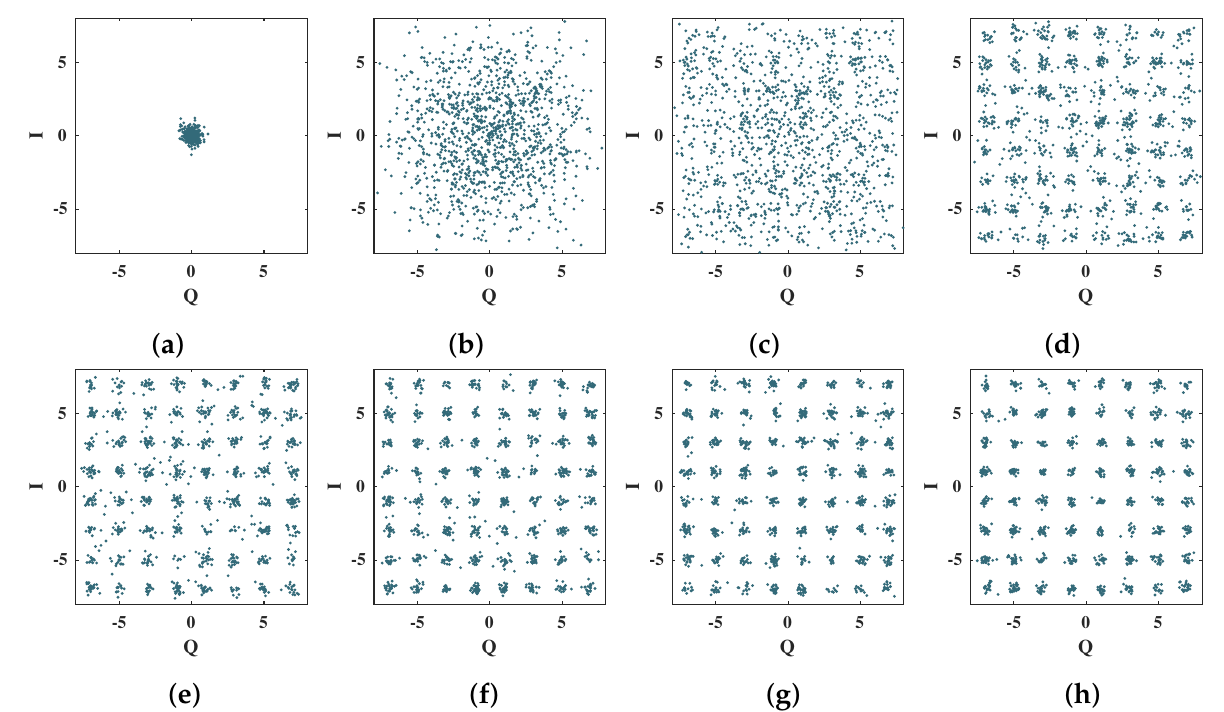
Figure 14. Scatter plots for the 64-QAM symbols at the output of the MMPTRBF in the training phase, for M T = M R = 4 antennas and E b / N 0 = 26 dB. ( a ) 1 epoch, ( b ) 1000 epochs, ( c ) 2000 epochs, ( d ) 3000 epochs, ( e ) 4000 epochs, ( f ) 5000 epochs,